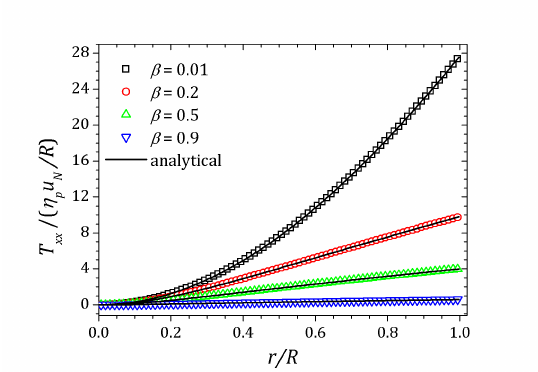
Figure 4. Normal stress for a PTT flow in a pipe.